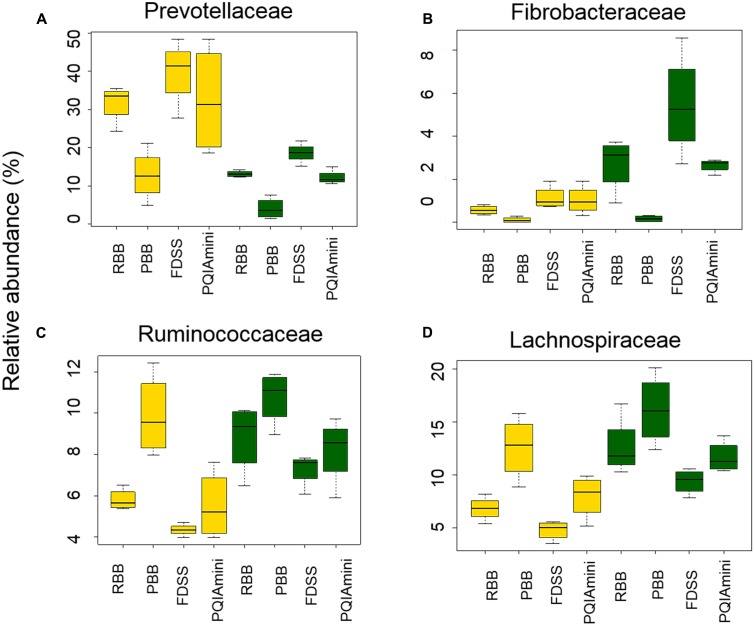
The effect of DNA extraction method (RBB, PDD, FDSS, and PQIAmini) on the relative abundance of the bacterial families Prevotellaceae (A), Fibrobacteraceae (B), Ruminococcaceae (C), and Lachnospiraceae (D) in rumen fluid (yellow) and fibrous content (green) samples. The boxplots represent the data from 5 observations per rumen fraction, and show the 25th, 50th and 75th percentiles, with whiskers showing the extremes of the data.